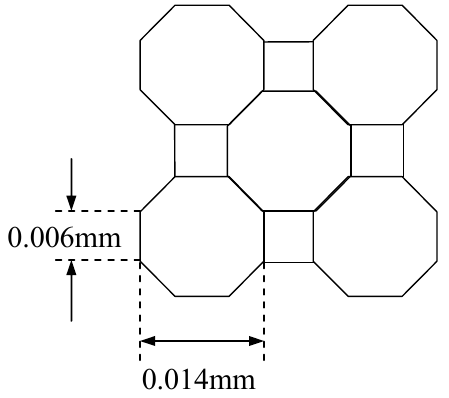
Figure 5. Actual measurements of octagonal-square shaped